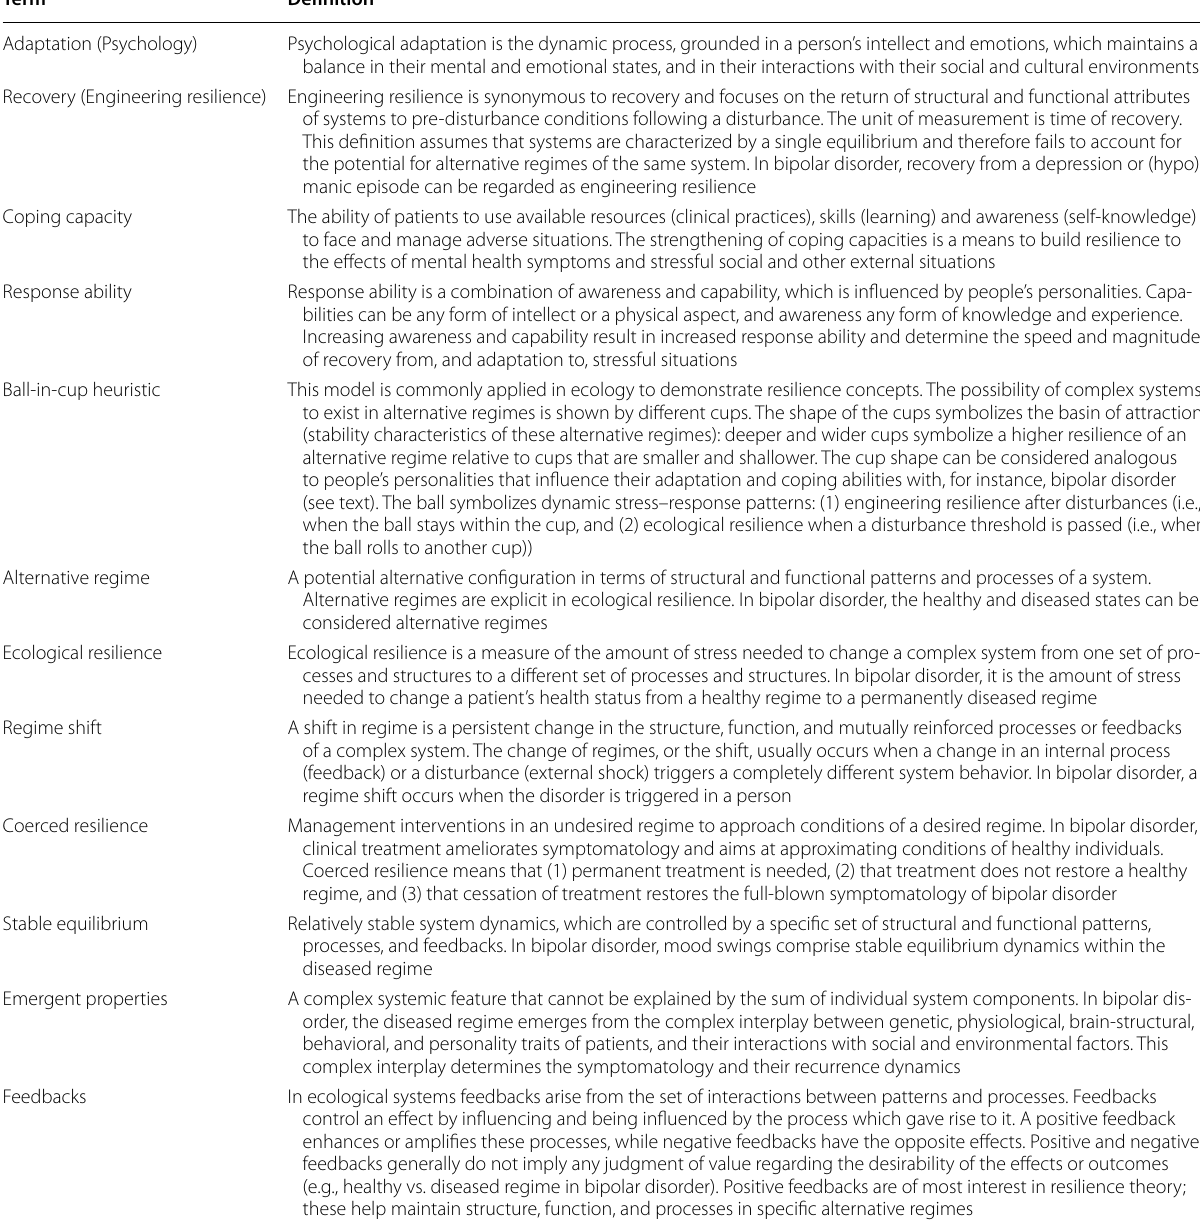
Table 1 Overview and definitions of terms used in this paper adapted from Angeler and Allen (2016) Term Definition Adaptation